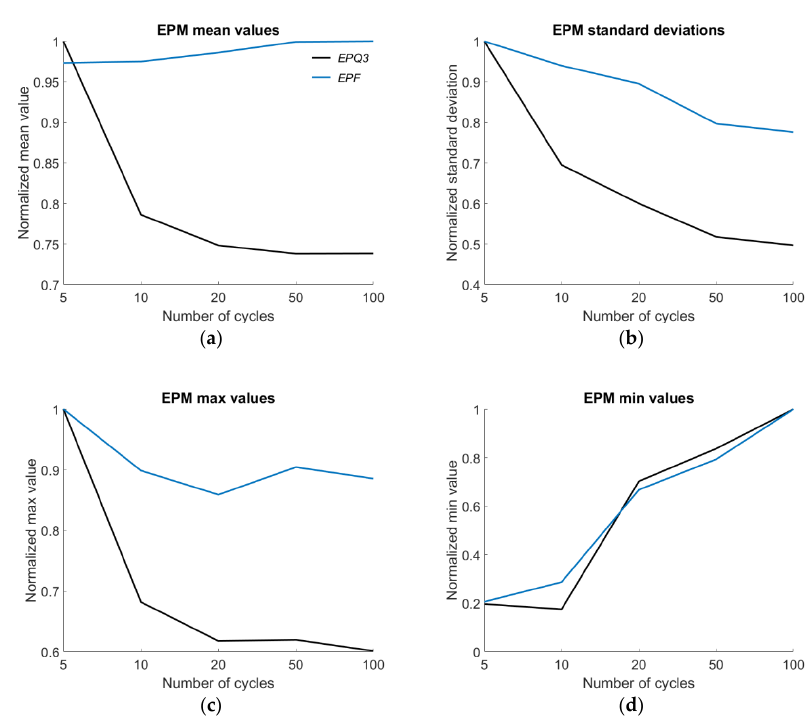
Figure 7. Energy Perturbation measures (EPM): ( a ) normalized group means, ( b ) standard deviation, ( c ) maximum value, ( d ) minimum value.